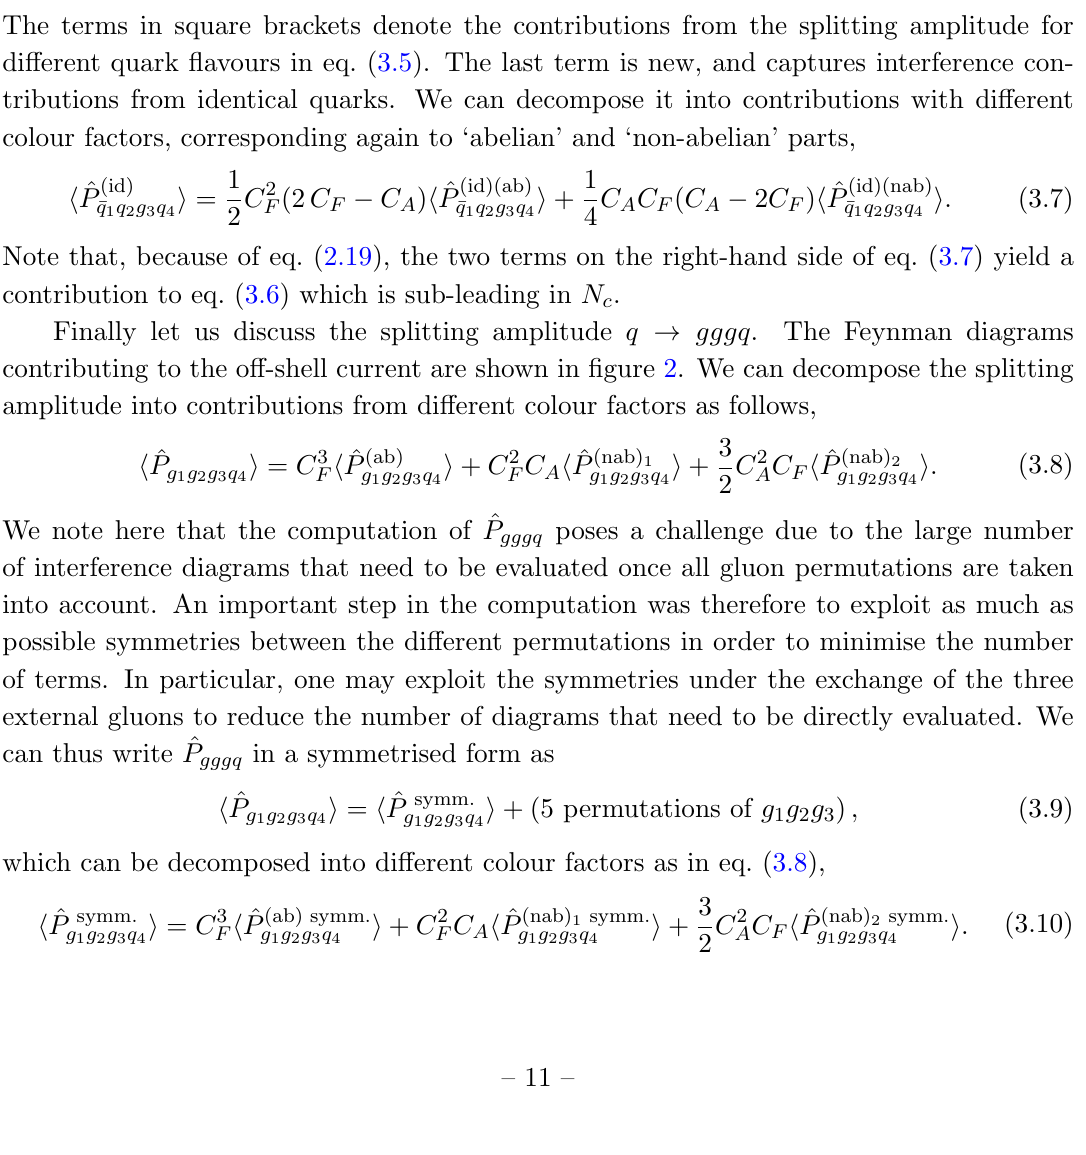
= q 4 , we also need to include the diagrams with q ′ 2